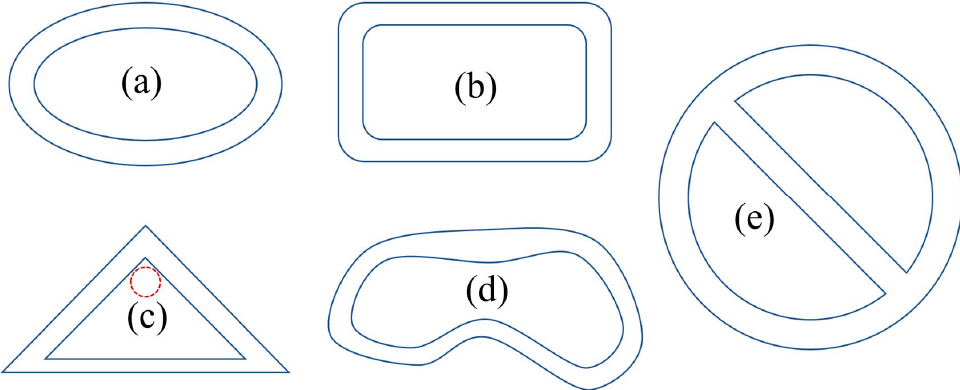
Figure 17. Various noncircular RDE cross-section configurations: ( a ) oval-shaped, ( b ) rounded- rectangular, ( c ) triangular, ( d ) arbitrary-shaped with changing width, and ( e ) connected channels [1].